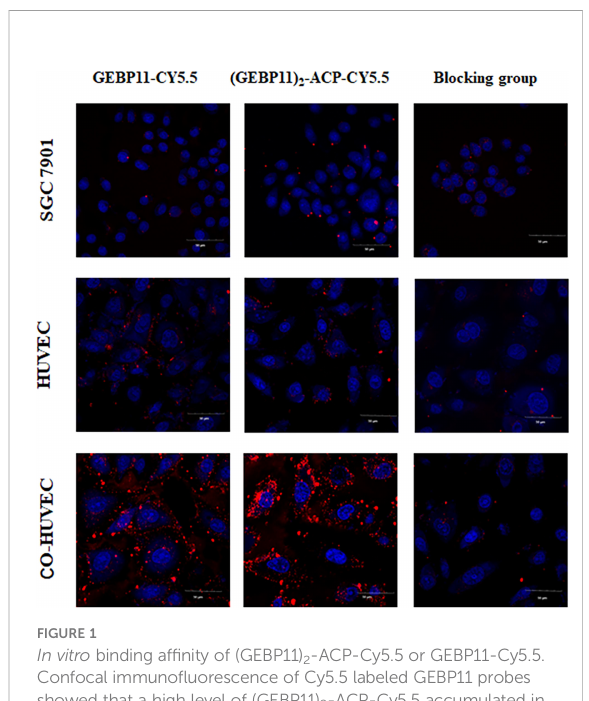
FIGURE 1 In vitro binding af fi nity of (GEBP11) 2 -ACP-Cy5.5 or GEBP11-Cy5.5. Confocal immuno fl uorescence of Cy5.5 labeled GEBP11 probes showed that a high level of (GEBP11) 2 -ACP-Cy5.5 accumulated in the Co-HUVECs. The competitive inhibition assay demonstrated the suppressive effect of GEBP11-Cy5.5 binding to Co-HUVECs by GEBP11. Cells were stained with DAPI in blue, and Cy5.5 labeled probes colored in red. Scale bar, 50 m